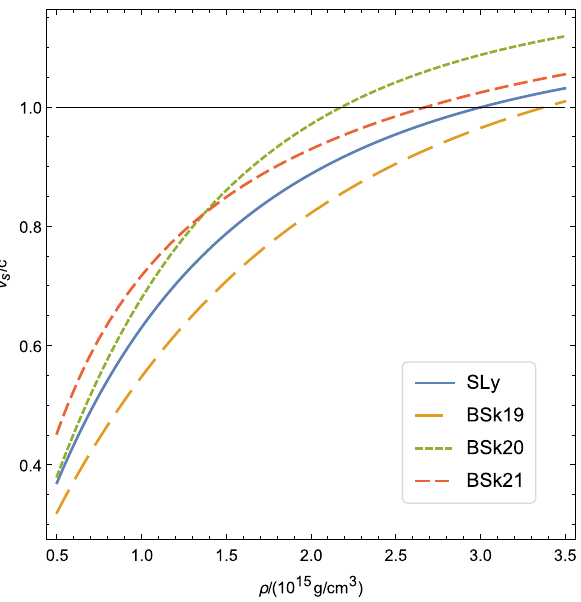
Fig. 1 The speed of sound v s as a function of the stellar density ρ for the EOSs SLy, BSk19, BSk20, and BSk21. The horizon line marks the causal limit v s =